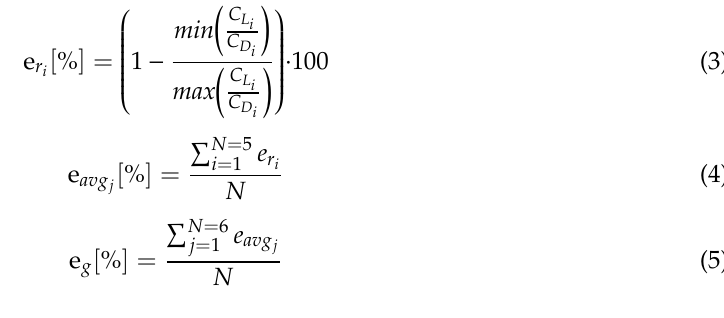
Table 2. Relative error (%) per MT configuration case. Average errors are shown in the last row.